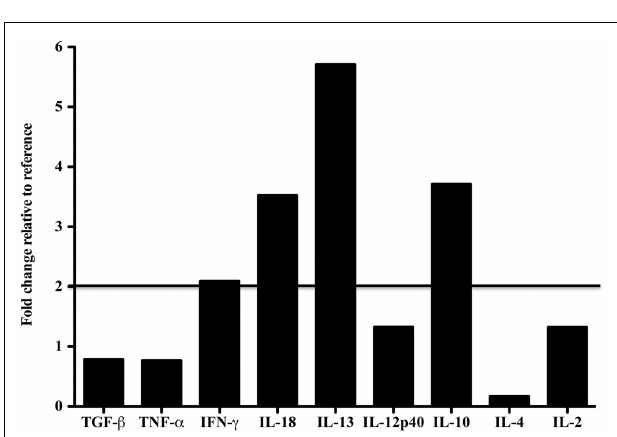
FIGURE 3 | Cytokine message levels in the spleen of a dolphin with hyperinsulinemia . In the spleen, each target gene was determined by real-time PCR and normalized first to S-9, a ribosomal control gene to give a ∆ Ct.The ∆∆ Ct was determined for the dolphin with hyperinsulinemia by normalizing to a healthy control.The ∆∆ Ct were transformed (2 ∼ ∆∆ Ct ) to show the expression of each cytokine message as a fold change. A fold change of 2 or more was considered to be upregulated in the dolphin with